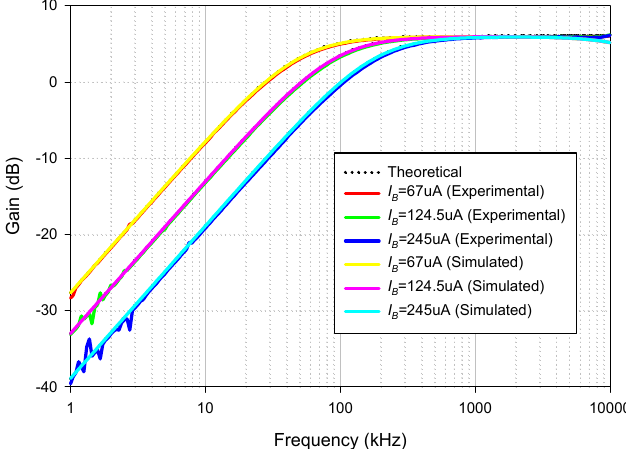
Figure 10. Frequency gain response of HP with different I B values.